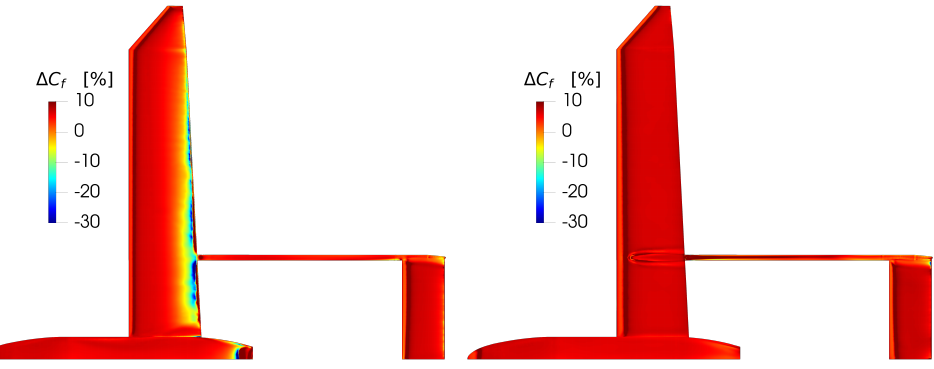
Figure 11. Percentage of skin friction reduction on the upper ( left ) and lower ( right ) parts of the aircraft in cruise condition.